Question: Provide a one-line summary of what is displayed.
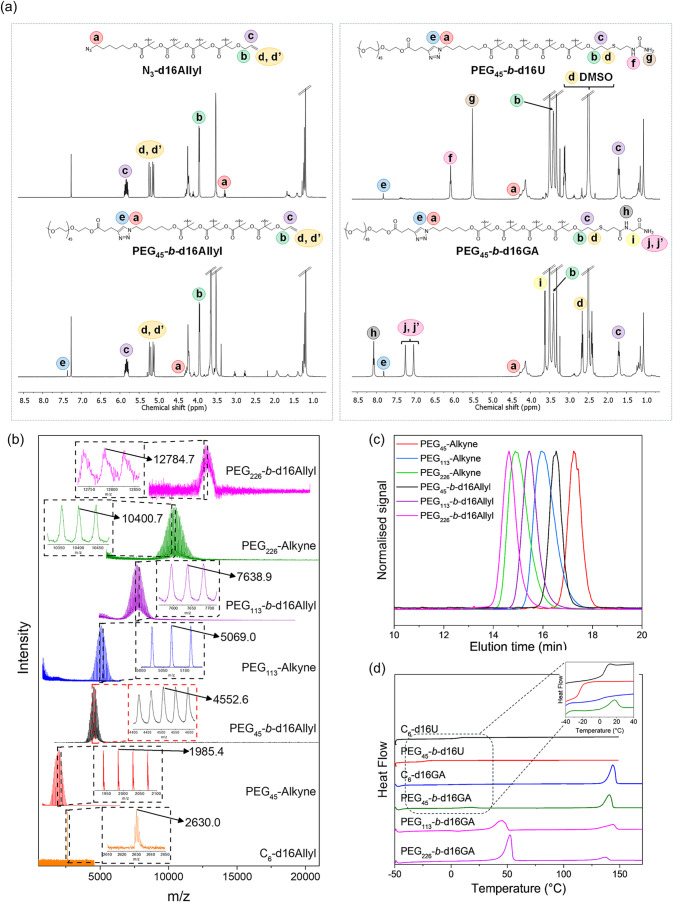
Answer: (a) 1 H NMR (400 MHz, CDCl 3 ) spectra of N 3 -d16Allyl and PEG 45 - b - d16Allyl and 1 H NMR (400 MHz, DMSO-d 6 ) spectra of PEG 45 - b - d16U and PEG 45 - b -d16GA . (b) MALDI-TOF mass spectra with expanded insets, and (c) SEC traces of PEG m -Alkyne and PEG m - b -d16Allyl . (d) DSC curves corresponding to the second heating scan of model dendrons and LDBCs registered at a 10 °C min –1 rate (exo down).